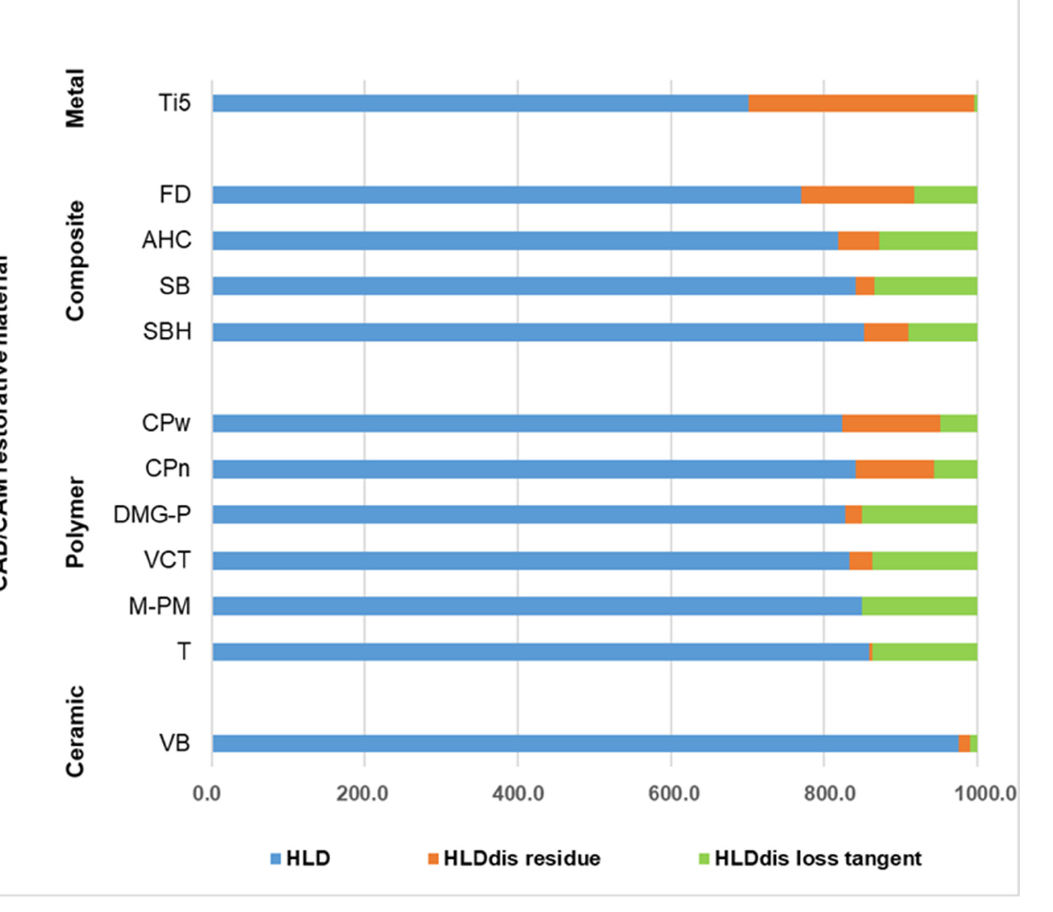
Figure 7. Devised diagram to facilitate interpretation of energy allocation during impact load. Figure 4 was used as a basis and all lengths of green bars were calculated defining the determined loss tangent values of M-PM as 100% HLD dis .